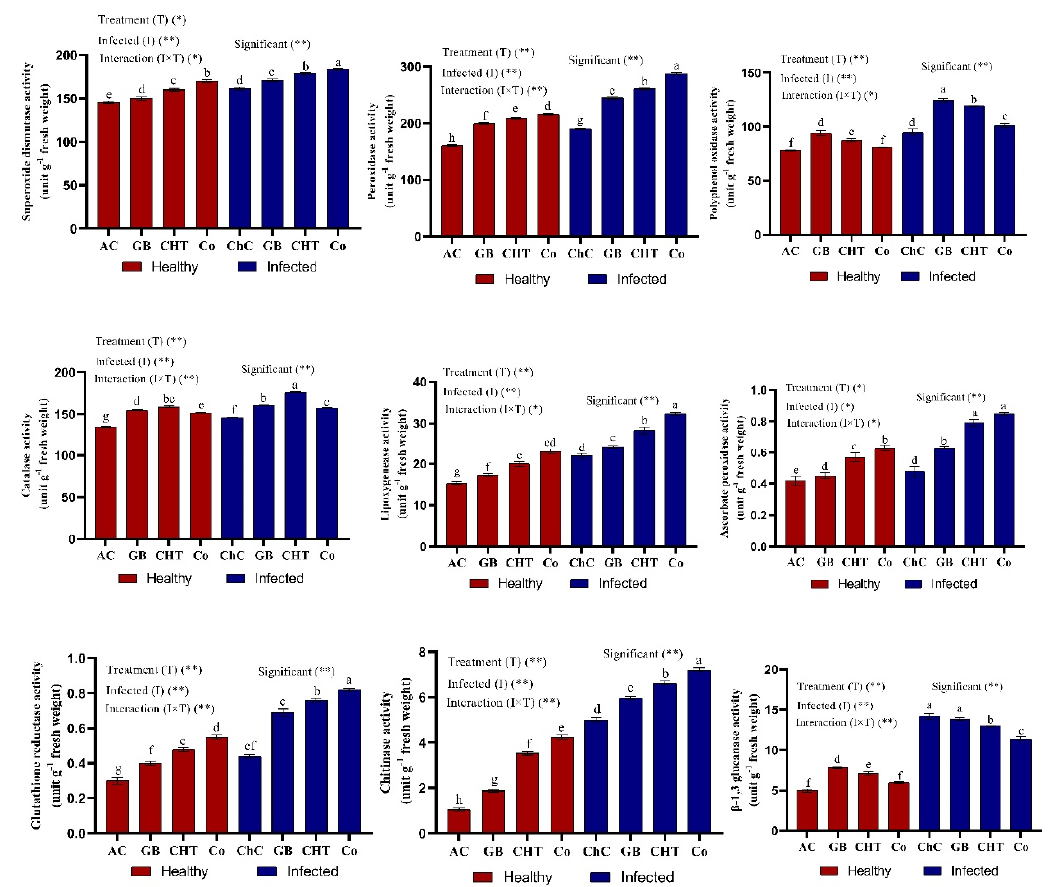
Figure 6. Effect of foliar spray by glycine betaine (GB), chitosan (CHT) and combination (Co) on enzymatic antioxidants content in leaves of cucumber plant under absolute control (AC) and CMV infection (challenge control, ChC) after 21 days of inoculation. Means with the different letters (a, b, c, d, e, f, g) are significantly different at the 0.05 level among treatments according to Tukey’s test. Vertical bars represent means of three independent determinations ± standard error (SE). * and ** indicate significant and highly significant difference according to two-way ANOVA with Tukey’s post hoc test.